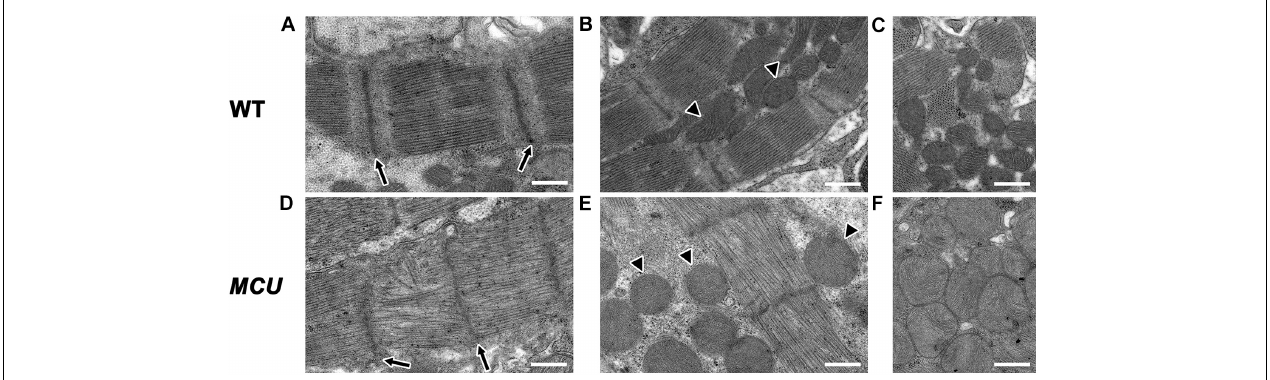
FIGURE 3 | Transmission electron microscopy analysis of MCU mutant ventricles. Representative TEM images of WT (A–C) and MCU (D–F) ventricular cardiomyocytes. (A,D) WT sarcomeres display clear Z -lines (arrows in A ) separated by parallel bands of myosin thick filaments. MCU Z -lines are less well defined and patchy (arrows in D ) and thick filaments are sometimes disorganized. (B,C) WT myofibrils are closely associated with oval-shaped mitochondria containing tightly packed cristae (arrowheads in B mark examples, C shows more examples). (E,F) MCU myofibrils are also closely associated with mitochondria, but they are less electron-dense and display a round and swollen morphology with more loosely packed cristae [arrowheads in (E) mark examples, (F) shows more examples]. Scale bars indicate 500